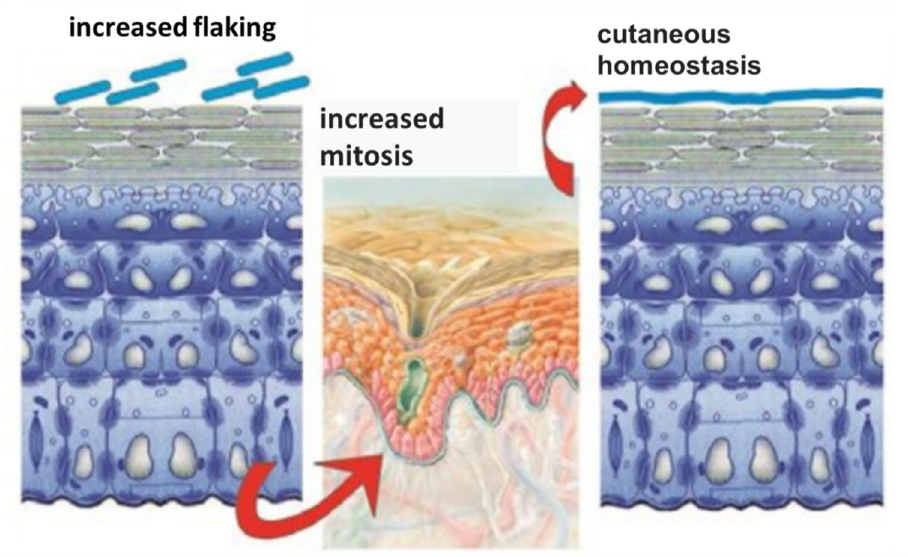
Figure 3. The normal skin turnover.